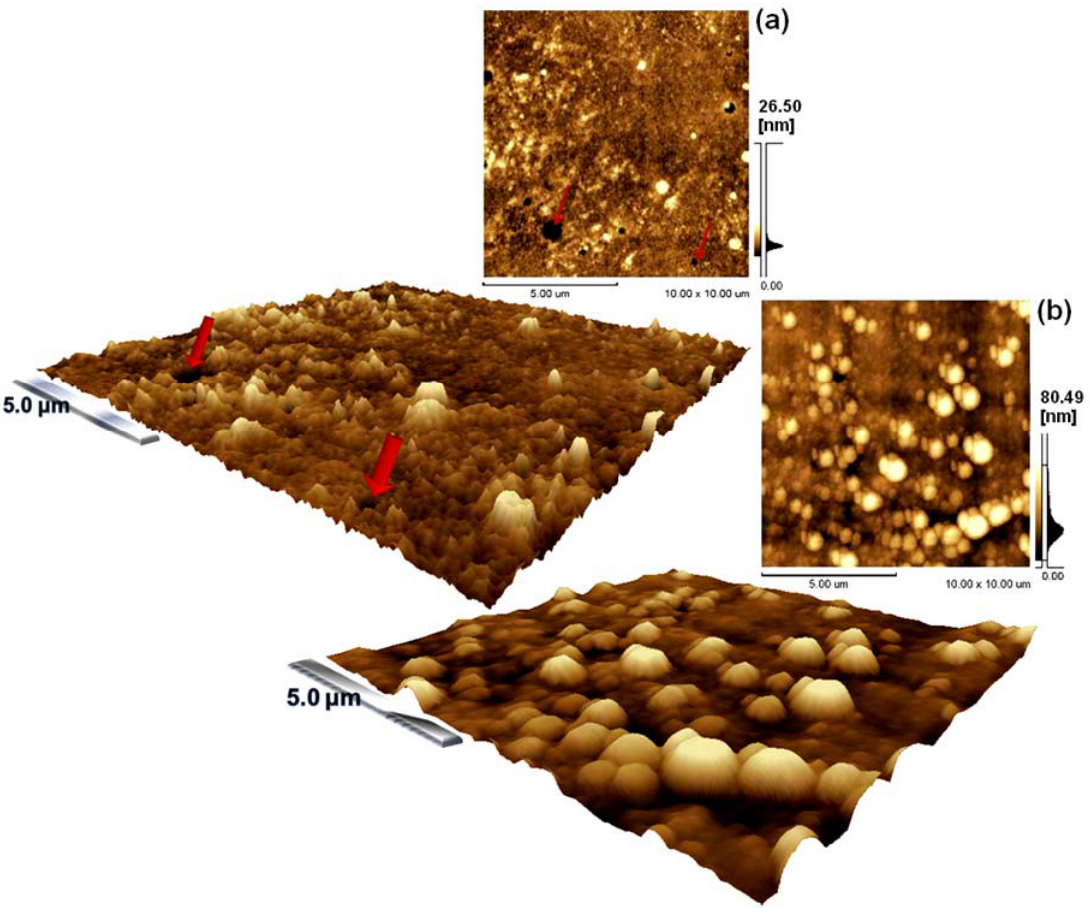
Figure 3. AFM micrographs of PEDOT-PSS doped with MR and deposited at (a) 2,000 rpm or (b) 1,000 rpm. Red arrows indicate defects on the thin film surface in (a). All images are 10 μ m × 10 μ m of size